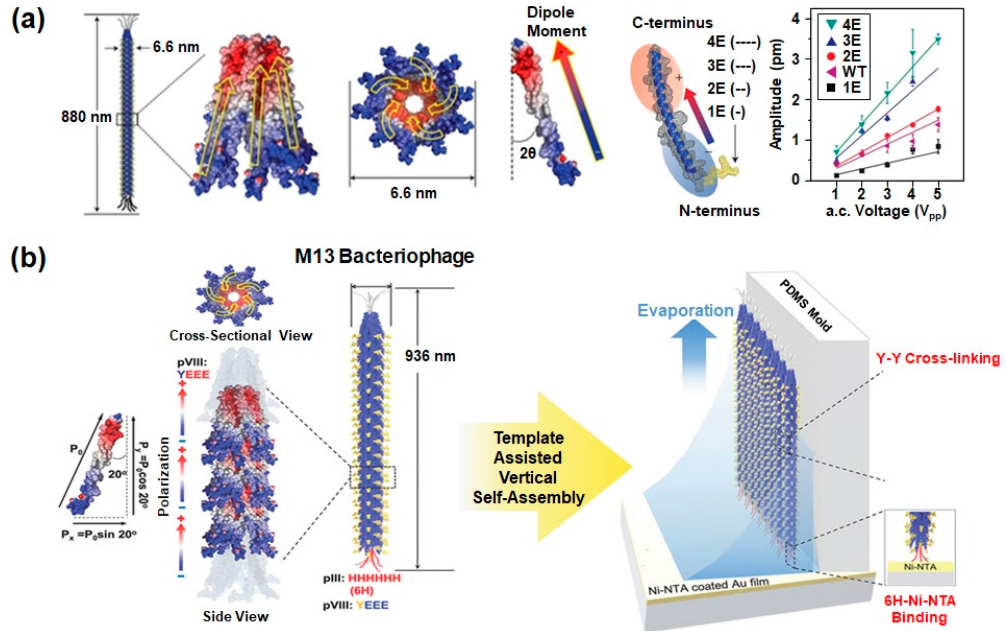
Figure 3. Surface modification of M13 bacteriophages through genetic engineering. ( a ) AEGDP (1E), AEEGDP (2E), AEEEGDP (3E), and AEEEEDP (4E) peptide sequences were expressed on the outer surfaces of the pVIII major coat protein of phages to enhance the piezoelectric properties. The M13 phage is 880 nm in length and 6.6 nm in diameter, which is covered by 2700 pVIII coat proteins and has five copies each of pIII and pIX proteins. The dipole moment is directed from the N-terminus (blue) to the C-terminus (red). Reproduced with permission from [28]. Copyright Nature Research, 2012. ( b ) HHHHHH peptide sequence expressed at the end of the N-terminus of the pIII minor coat protein for specific binding of phages on the Ni-NTA surface. The YEEE peptide motif is expressed between the first and fourth residues at the N-terminal of the pVIII major coat protein to enhance the mechanical stability by Y-Y cross-linkage. Reproduced with permission from [29]. Copyright American Chemical Society,